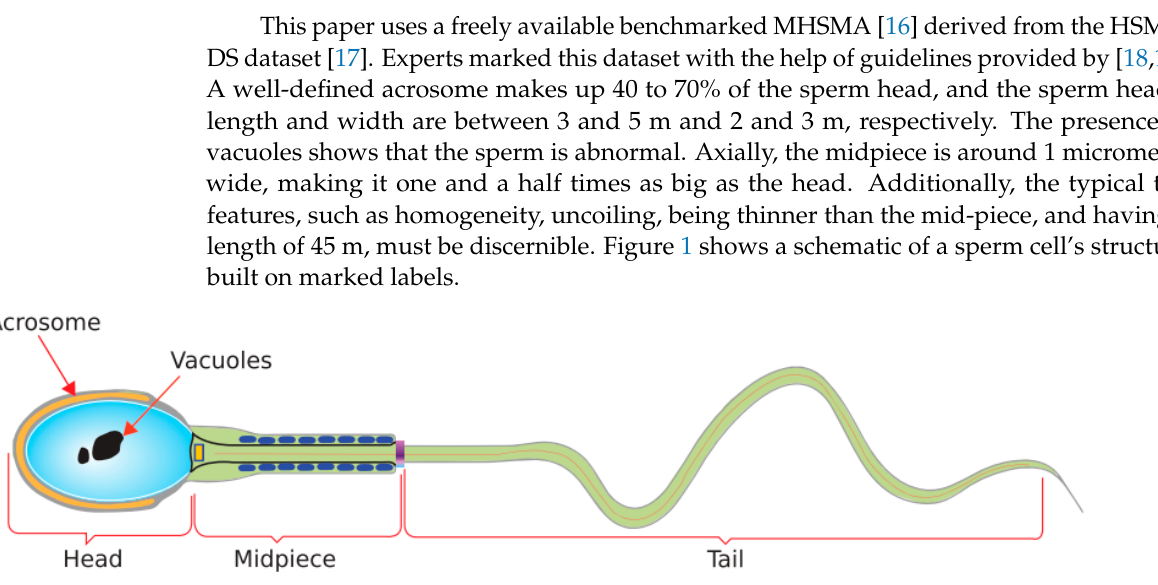
Figure 1. Sperm cell’s structure based on annotated labels.